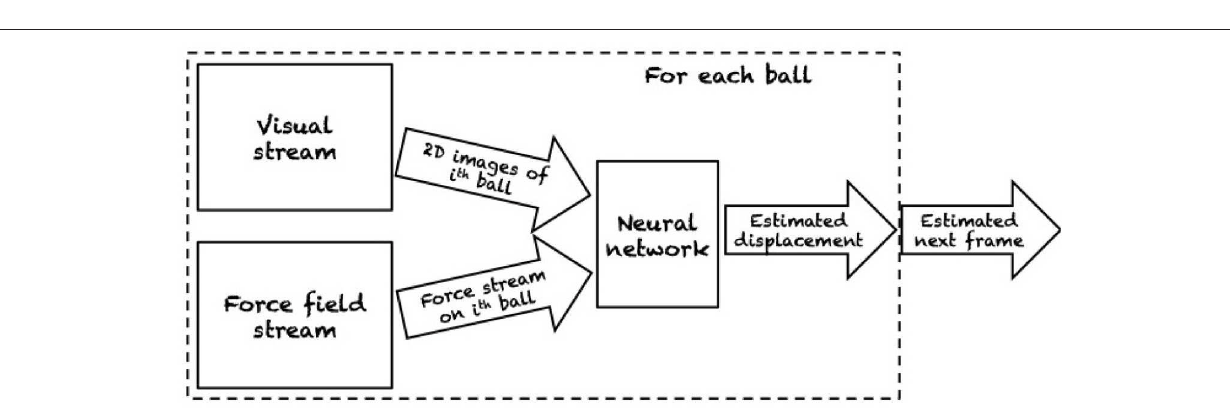
FIGURE 11 | Object-centric model for motion prediction of billiard balls. The system predicts the future configurations of the balls by individually modeling the temporal evolution of each ball. In this scenario, predicting the velocities of each ball is sufficient for computing the next configuration of the billiard. Reproduced from Fragkiadaki et al.